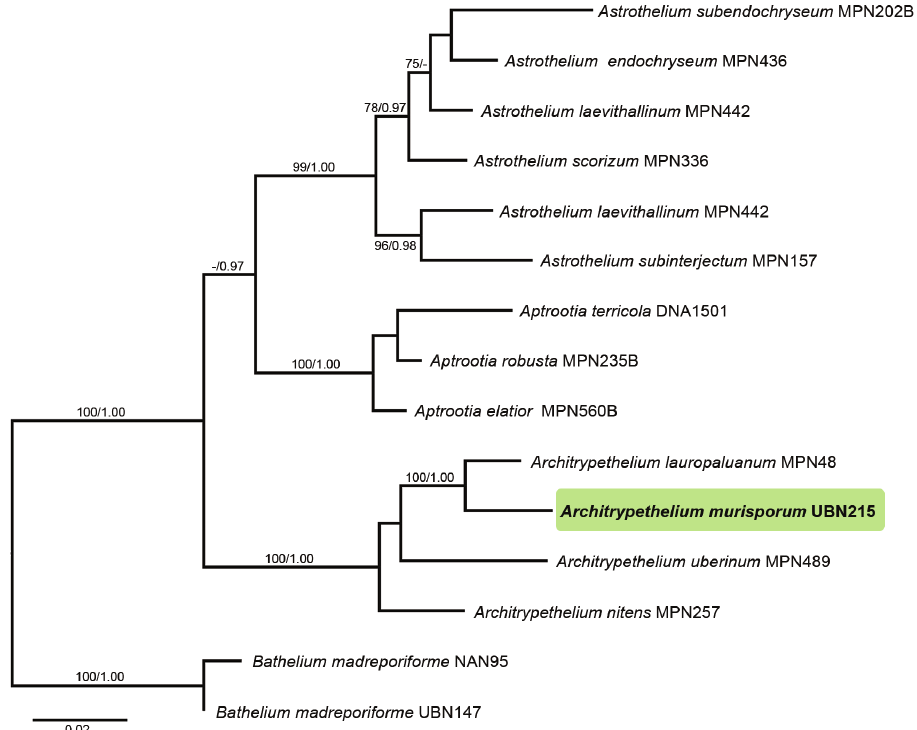
Figure 1. Phylogenetic relationships of Architrypethelium and sister genera based on a combined data set of two DNA loci (mtSSU and nuLSU rDNA). Bootstrap values ≥ 70% and posterior probabilities ≥ 0.95 are shown at above and below